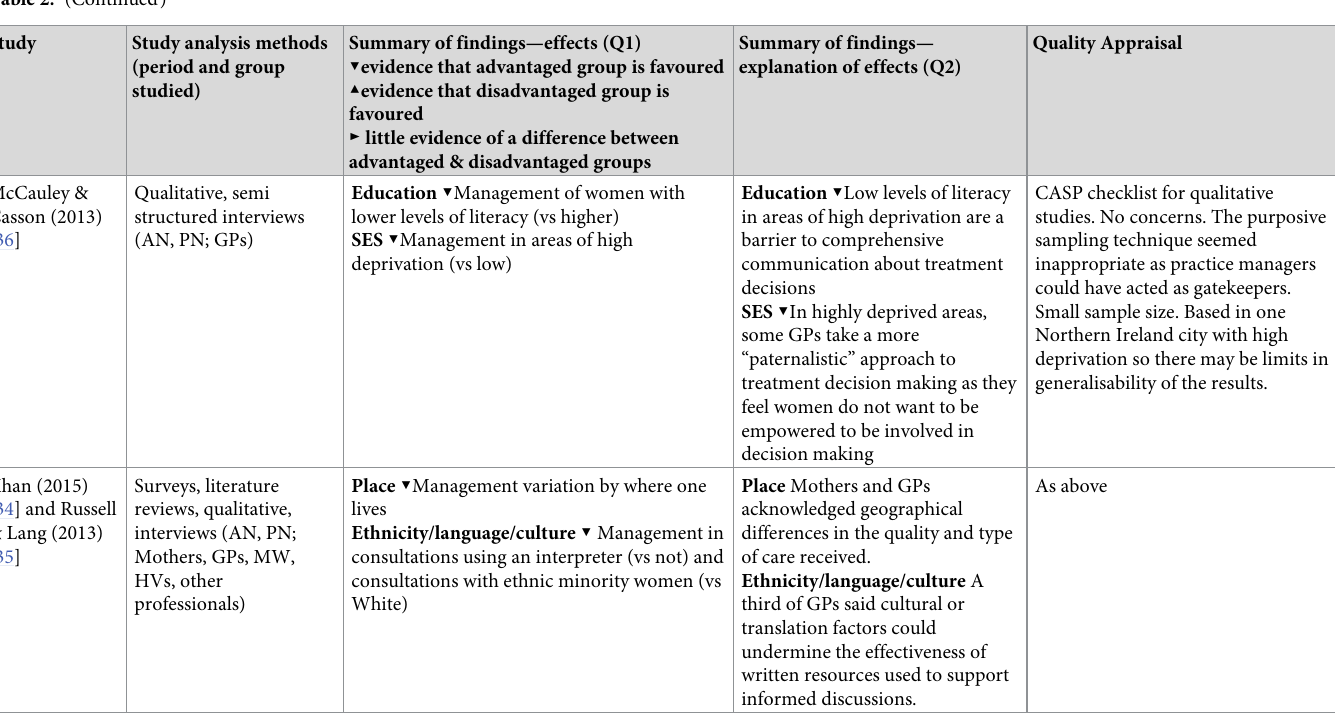
Detection. Five papers explored the detection of perinatal mental health problems (Table 2). The following ordering represents the organising categories in PROGRESS-Plus. Language , ethnicity and migration . Five studies investigated or reported detection by ethnic- ity or language, no studies investigated detection by migration. Two of the studies had quality concerns; one over the under-representation of disadvantaged groups for one study [38] and uncertainty around sampling for the second [34, 35]. Differences in detection in relation to ethnicity or language were found in antenatal and postnatal studies. Comparing scores from the GHQ-28 in pregnancy to recording of informa- tion in GP data, Prady et. al. [22] found that women who were not White British were more than twice as likely to have potentially unidentified antenatal CMD, and less than half as likely to have a case-finding attempt recorded. The recording of the case finding attempt was lowest in women who spoke in their first language, which was not English. The majority of non- White British women in this study were of Pakistani origin. Redshaw and Henderson [38] found that Asian women, but not women of other ethnicity, were less likely to be asked about current, past or familial mental health problems compared to White women in the antenatal period. In this study, women were not asked to indicate whether they identified with being ‘British’, and were classified as White, Mixed, Black, Asian or other. In the postnatal period fewer women of any non-White ethnic group were asked about their mental health compared to White